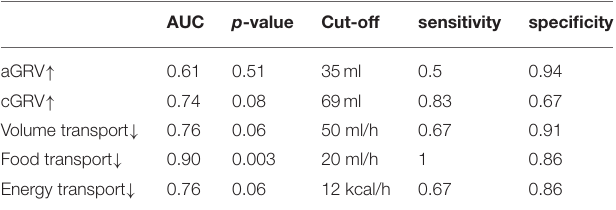
TABLE 2 | Evaluation of parameters of gastric emptying as classifiers for feeding